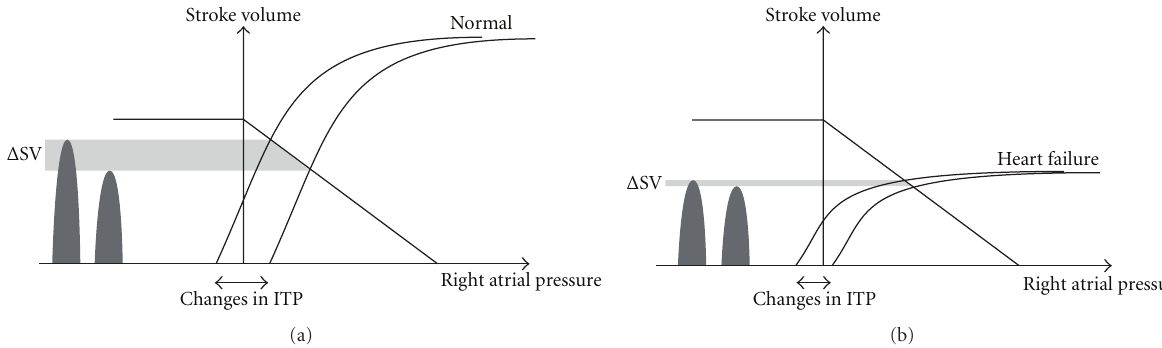
Figure 5: The e ff ect of intrathoracic pressure on cardiac output. Both spontaneous breathing and mechanical ventilation result in a cyclical change in intrathoracic pressure (ITP). Depending on the mode of ventilation, the change in ITP is accompanied by a cyclical shift in the Frank-Starling (cardiac function) curve which results in a cyclical change in preload. If the crossing point is on the steep part of the curve, shifting of the curve would result in a change in stroke volume (SV) (or cardiac output). This respiratory induced cyclical change in SV is known as SV variation (a). In heart failure, such change in SV may be less apparent because the crossing point is at the flat portion of the curve